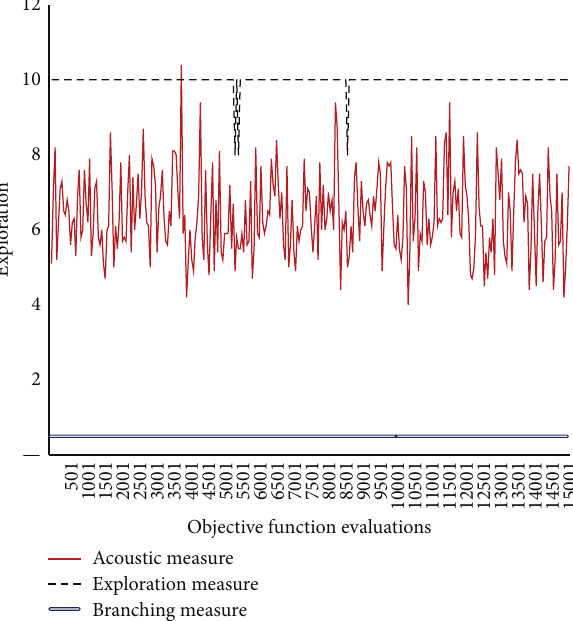
Figure 6: Evaluating ACO ustic against traditional indicators in ACO for the QAP instance kra30a with nearest neighborhood threshold = 𝜖 8.